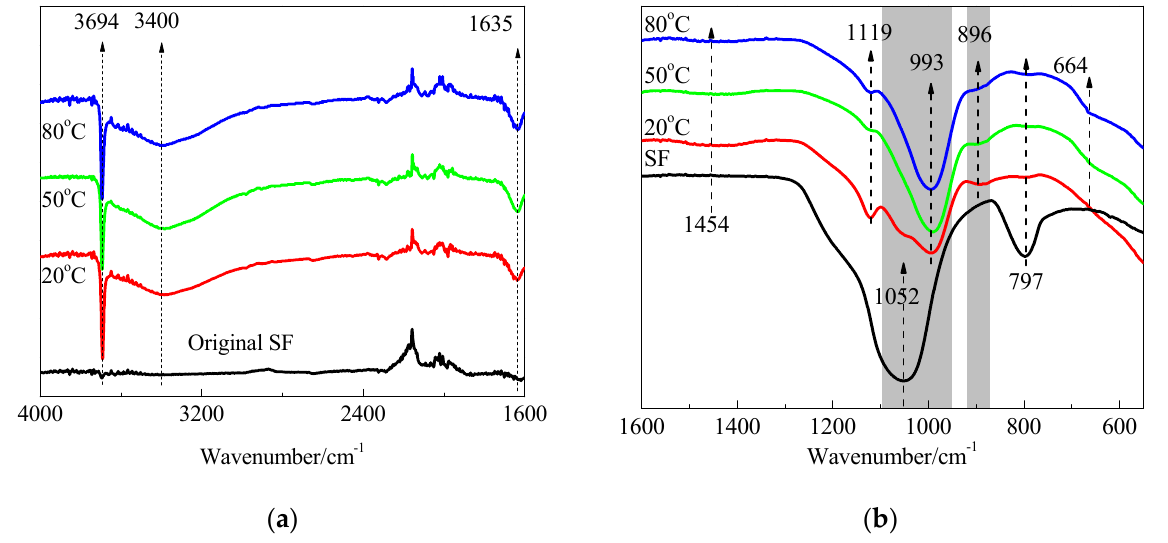
Figure 13. FTIR spectra of SF and MgO-SF pastes prepared using MgO calcined at 1450 °C for 30 min after 14 d: ( a ) 4000 cm − 1 –1600 cm − 1 and ( b ) 1600 cm − 1 –550 cm − 1 .